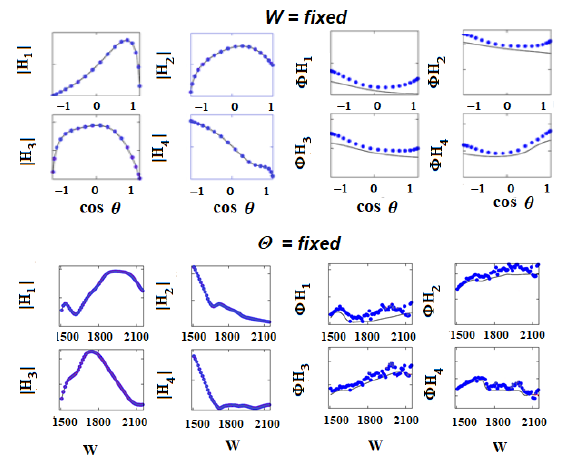
Figure 1: Absolute values and phases of helicity ampli- tudes at fixed energy and fixed angle obtained in uncon- strained SE-PWA for a complete set of MAID pseudo-data [19]. Full lines are predictions of ETA-MAID15a model, and full dots are the result of unconstrained SE-PWA. The absolute scale is unimportant to see the e ff ect.